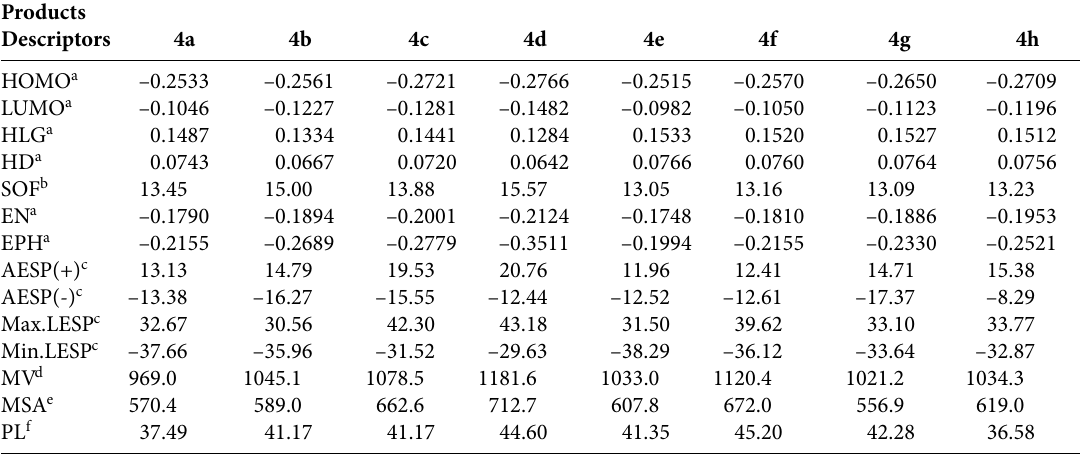
Table 4. The numerical values of the calculated